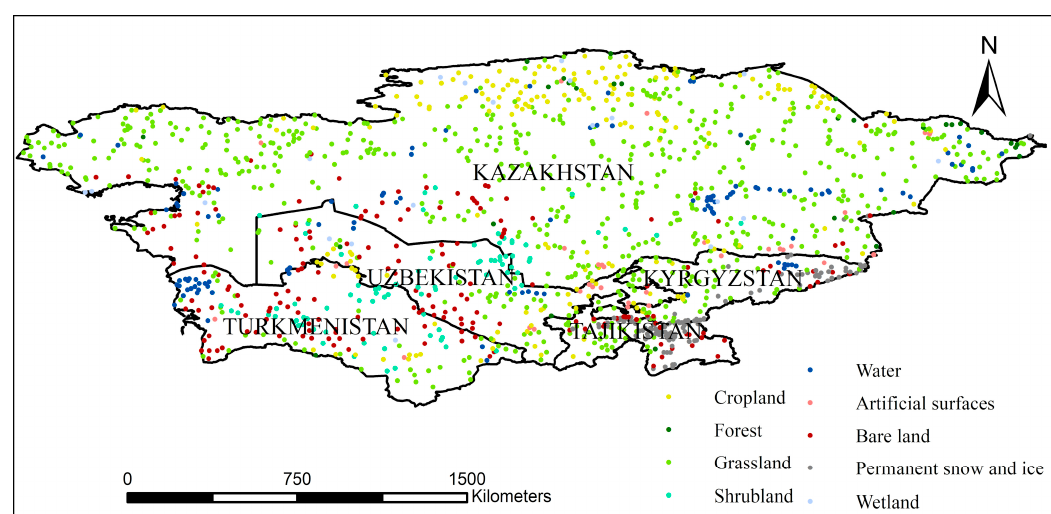
Figure 5. The distribution map of validation samples for landcover/use data accuracy test.